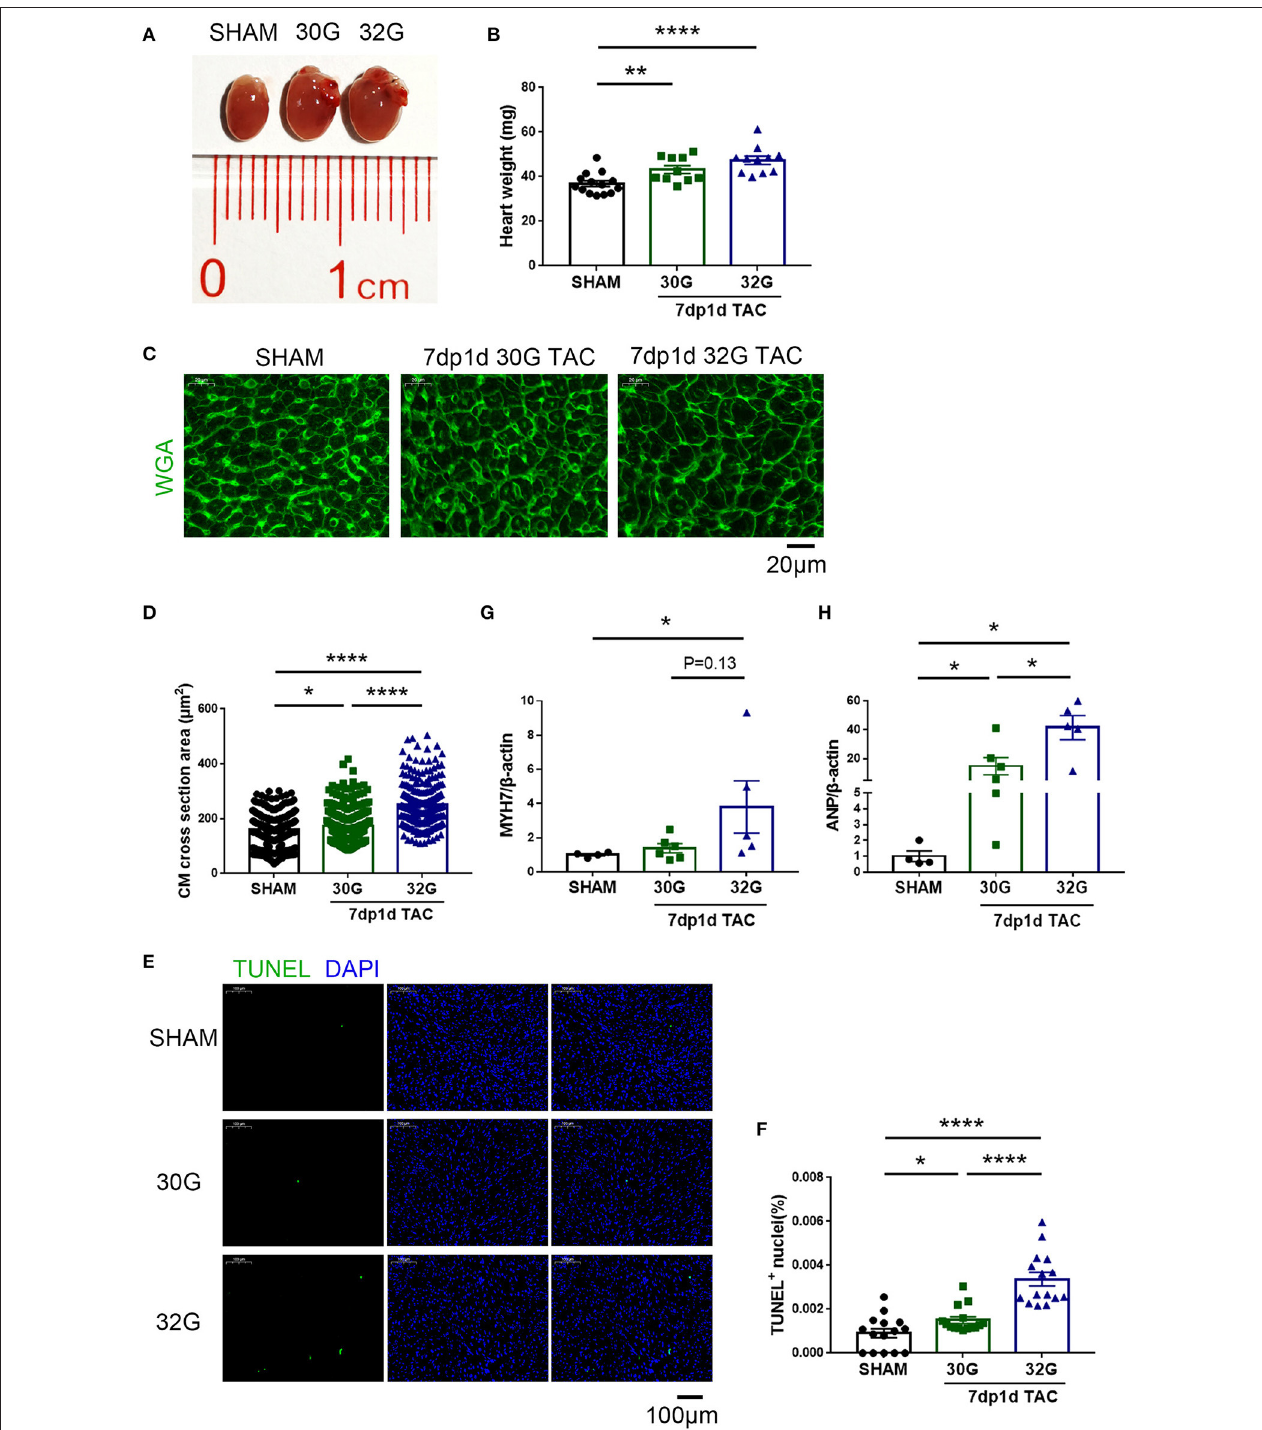
FIGURE 5 | Apoptosis and hypertrophy increased in mice 7 days after the 30G and 32G TAC surgery. (A) The hearts of mice in the sham (left), 30G TAC (middle), and 32G TAC (right) groups. (B) The heart weight analysis in the three groups: n = 14, sham; n = 10, 30G TAC; n = 11, 32G TAC. (C) Representative heart sections stained with WGA (green) in the three groups. Scale bar: 20 µ m. (D) Analysis of cardiomyocyte cross-sectional area in the three groups; n = 3 hearts per group. A total of 250-300 cardiomyocytes per group were analyzed. (E) Representative images of terminal deoxynucleotidyl transferase dUTP nick end labeling (TUNEL, green)-positive cells from the heart sections in the three groups. Scale bar: 100 µ m. (F) Statistical chart of TUNEL-positive cells in the three groups; n = 3 hearts per group. Each heart slide was random selected with five high-power fields for statistical analysis. (G,H) Quantitative real-time polymerase chain reaction (qRT-PCR)